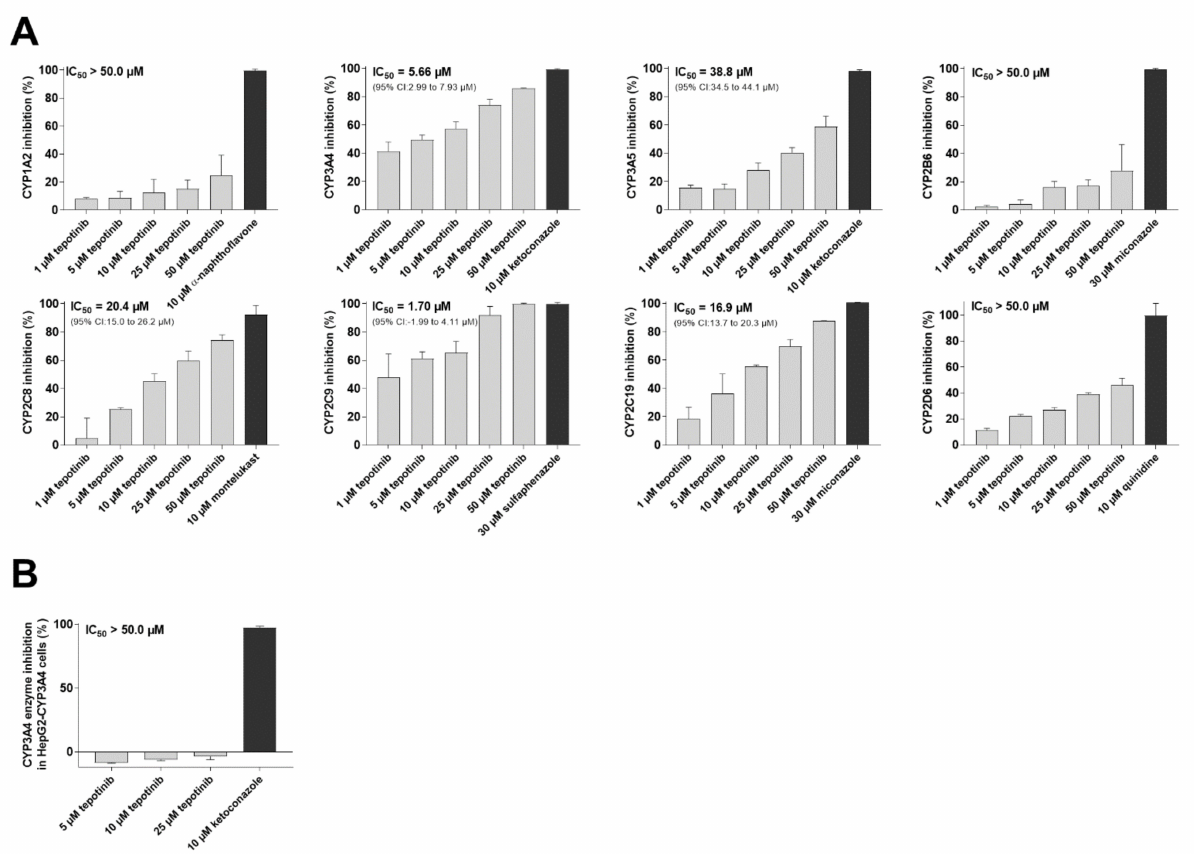
Figure 2. Effect of tepotinib on the activity of clinically relevant human CYP isoforms. ( A ) Screening of inhibition of recombinant enzymes by using Vivid CYP450 Screening Kits. Raw fluorescence data were normalized against control 0% and 100% activity values. Maximal (100%) control value was obtained from reaction that contained only the enzyme and 0.5% DMSO with no drug. Control 0% activity value was represented by sample consisting of 0.5% DMSO and the enzyme solvent buffer without the enzyme. 0.5% DMSO was present in all dilutions of tepotinib/model inhibitors to avoid results’ distortion by fluctuation in DMSO levels. ( B ) Effect on CYP3A4 metabolic activity in HepG2-CYP3A4 cells. Metabolic values were first normalized to viability data. Resulting values were then re-normalized as % of inhibition. Control value representing 100% activity was obtained from cells exposed to vehicle-containing media and IPA substrate, while 0% activity control came from cell-free wells, into which vehicle-containing media and IPA substrate were